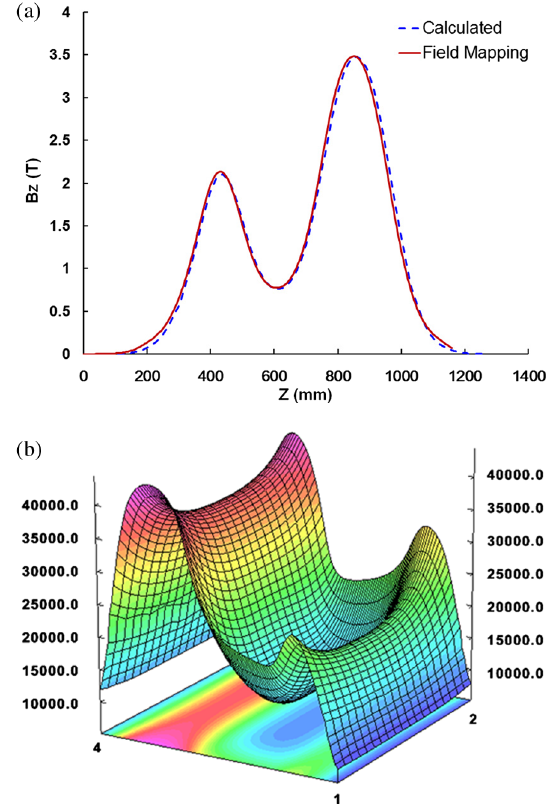
FIG. 9. SECRAL axial magnetic field distribution. (a) Designed axial mirror magnetic field (B z ) distribution on the axis for SECRAL 24 – 28 GHz operation. (b) 3D field distribution at the x-z plane in the plasma chamber.